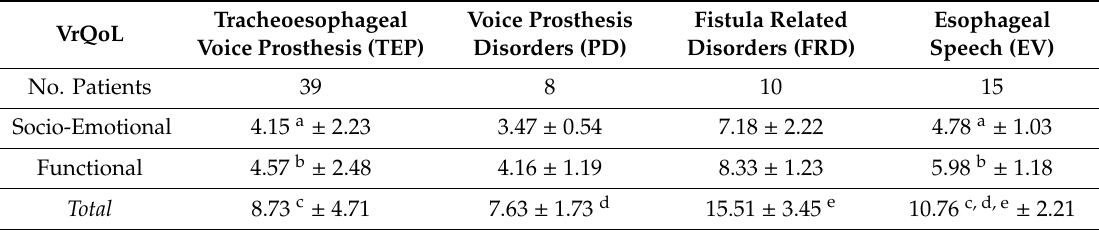
Table 3. Comparison of V-RQoL outcomes.